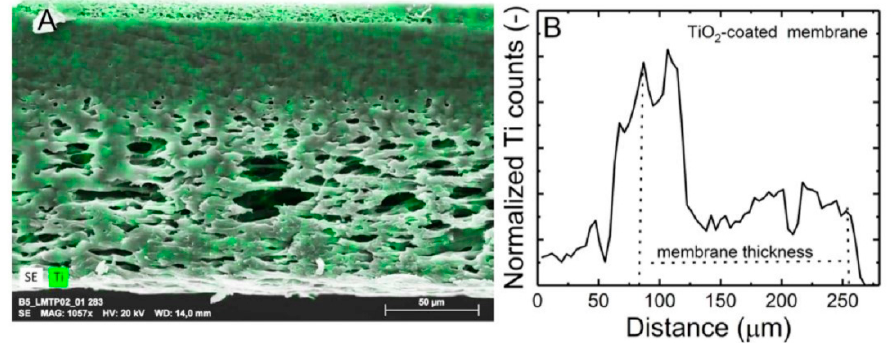
Figure 3. ( A ) Titanium (Ti) elemental mapping data obtained via EDX analysis overlaid onto the SEM image, scale bar 50 µ m; ( B ) EDX line scan through the corresponding membrane cross-section.